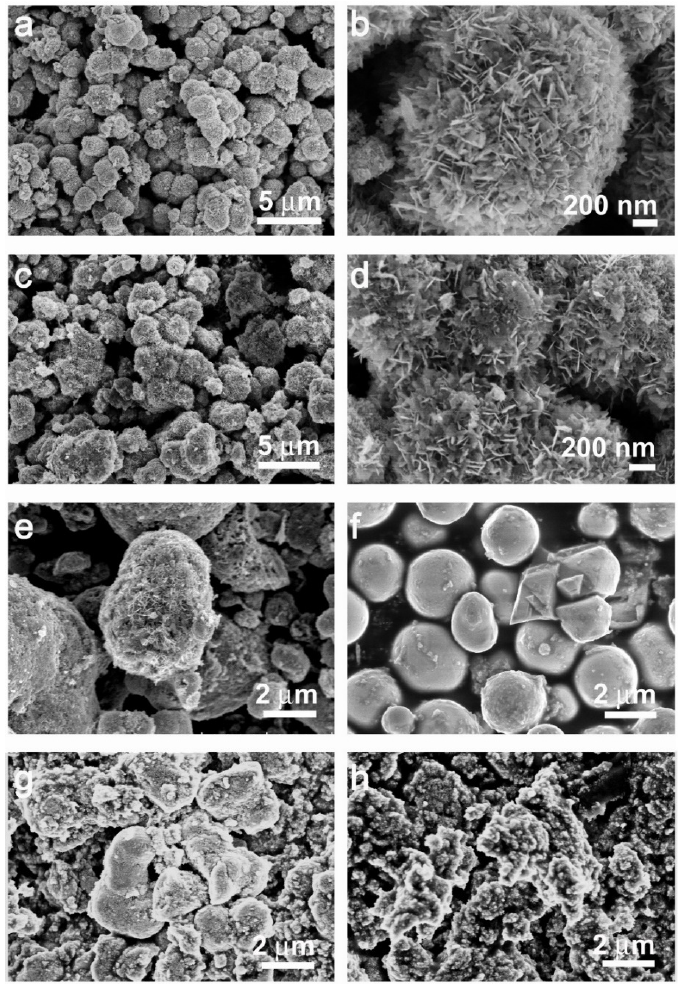
Figure 2. SEM images of BMO ( a , b ), BMO-CTAB ( c , d ), BMO-TCD ( e ), BMO-GLU ( f ), BMO-SDS-1 ( g ) and BMO-SDS-2 ( h ).